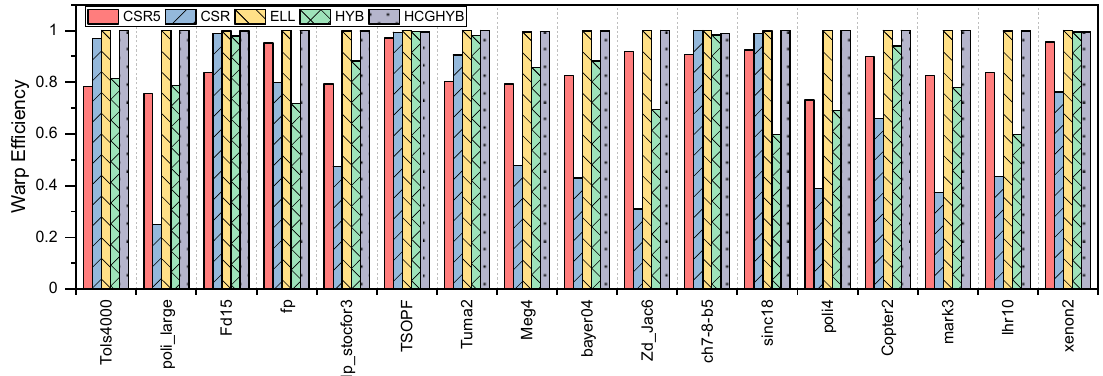
Figure 25. HCGHYB execution efficiency compared to CSR, ELL, HYB, and